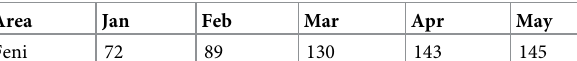
Table 2. Evapotranspiration (in mm) data in the Muhuri irrigation area. Area Jan Feb Feni